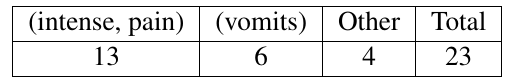
Table 4: Weak matching example for a partition associated to a query